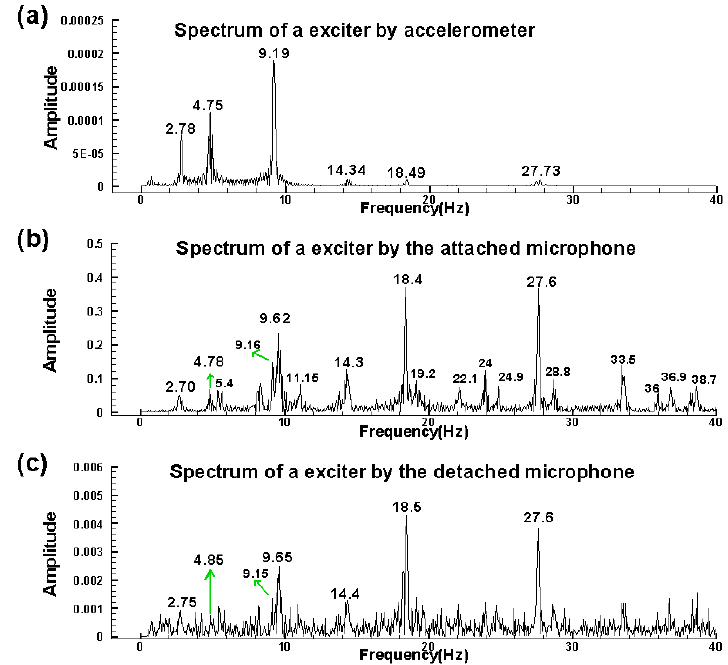
Figure 5. Spectra of three sensors: (a) the accelerometer. (b) microphone-1 attached to the membrane. (c) microphone-2 at 10 cm above the membrane.